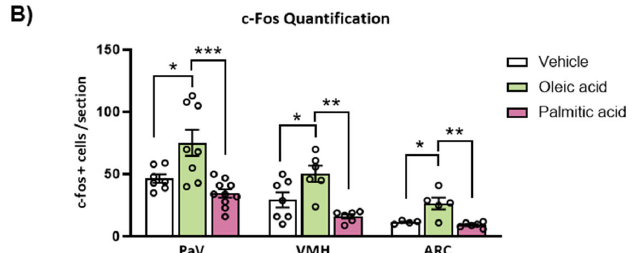
Figure 3. Effects of intracerebroventricular (ICV) administration of oleic acid and palmitic acid on neuronal activation on hypothalamic nuclei in WT mice. ( A ) Representative images and ( B ) quanti ‐ fication of immunohistochemistry for c ‐ Fos expression in paraventricular (PaV), ventromedial (VMH) and arcuate (ARC) nucleus of the hypothalamus after 48 h of ICV administration of fatty acids. Data are represented as mean ± SEM (n = 3 per group; 2–3 slices/mice). * p < 0.05, ** p < 0.01, *** p < 0.001 vs. vehicle from same nucleus. OA: oleic acid; LA: linoleic acid; PA: palmitic acid; SA: stearic acid; V: vehicle. 3V: third ventricle. Scale bar = 250 μ m. 2.4. Neuronal Activation Induced by Oleic Acid in the PaV and VMH Was Attenuated in the